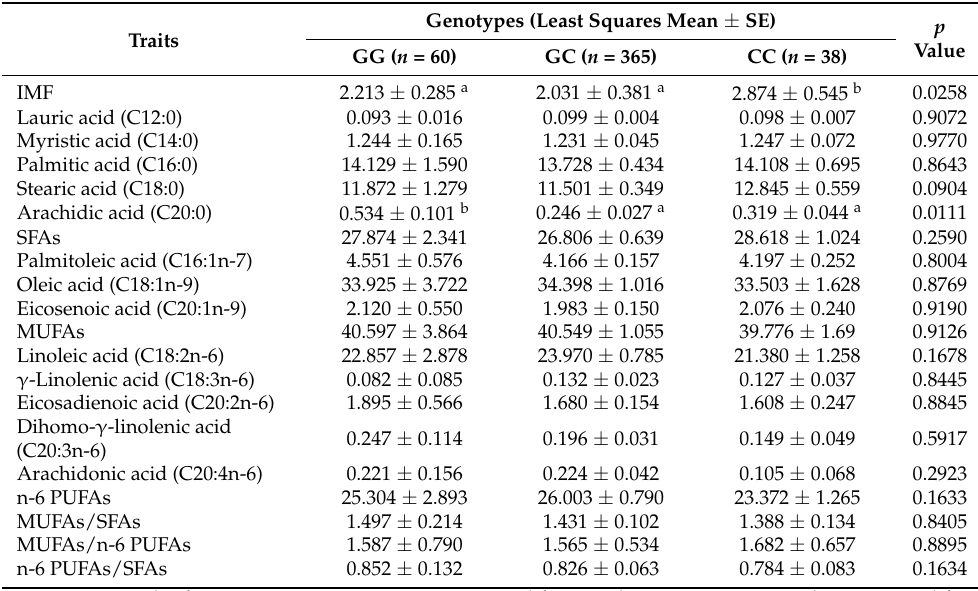
Table 4. Association of porcine TNFRSF19 c.860G > C gene with IMF content and FA composition traits in longissimus thoracis muscles of